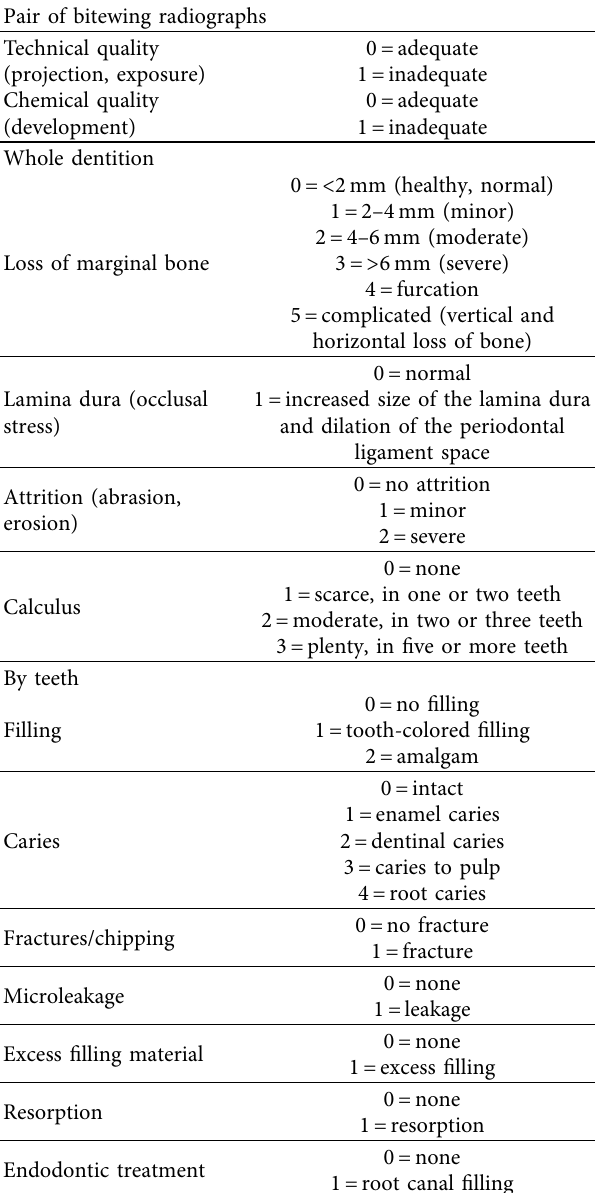
Table 1: The variables and their values used in the